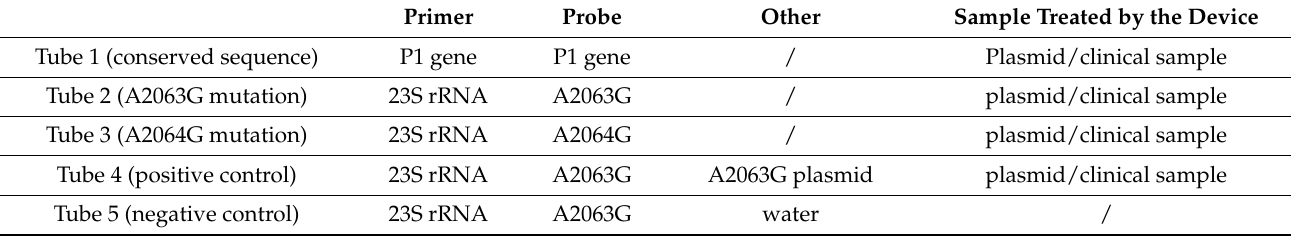
Table 1. qPCR solution composition after the preparation with the device (besides PCR mix). Primer Other Sample Treated by the